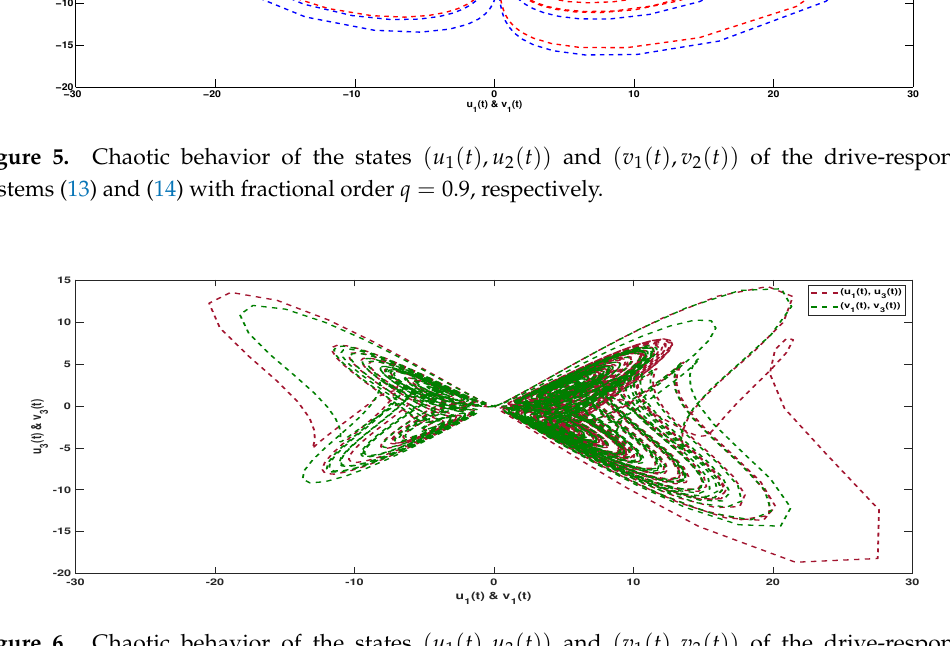
Figure 6. Chaotic behavior of the states ( u 1 ( t ) , u 3 ( t )) and ( v 1 ( t ) , v 3 ( t )) of the drive-response systems (13) and (14) with fractional order q = 0.9,